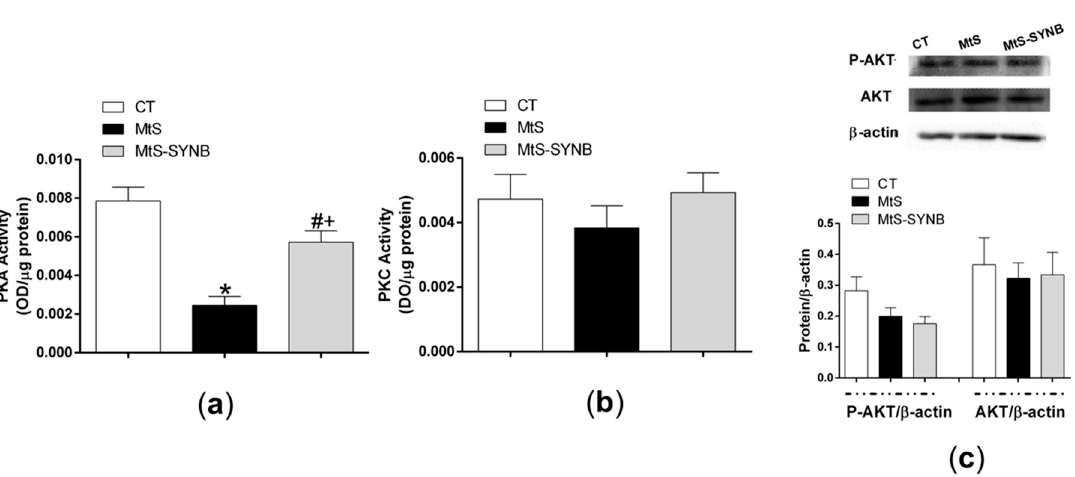
Figure 8. ( a ) PKA activity, and ( b ) PKC activity in mesenteric arteries from CT, MtS and MtS-SYNB rats. Results are represented as optical density (OD) units / µ g protein (mean ± S.E.M). Statistical analysis: One-way ANOVA followed by a Newman–Keuls post-hoc test. * p < 0.05 CT vs. MtS; # p < 0.05 MtS vs. MtS-SYNB; + p < 0.05 CT vs. MtS-SYNB. ( c ) Western blot analysis for total AKT (AKT) and phosphorylated AKT at the T308 residue (P-AKT) in mesenteric arteries from CT, MtS and MtS-SYNB rats. Each lane is representative of eight isolated arterial segments from di ff erent animals in each group. Lower graph shows densitometric analyses of the protein expression. Results (mean ± S.E.M) are expressed as protein expression relative to β -actin expression.